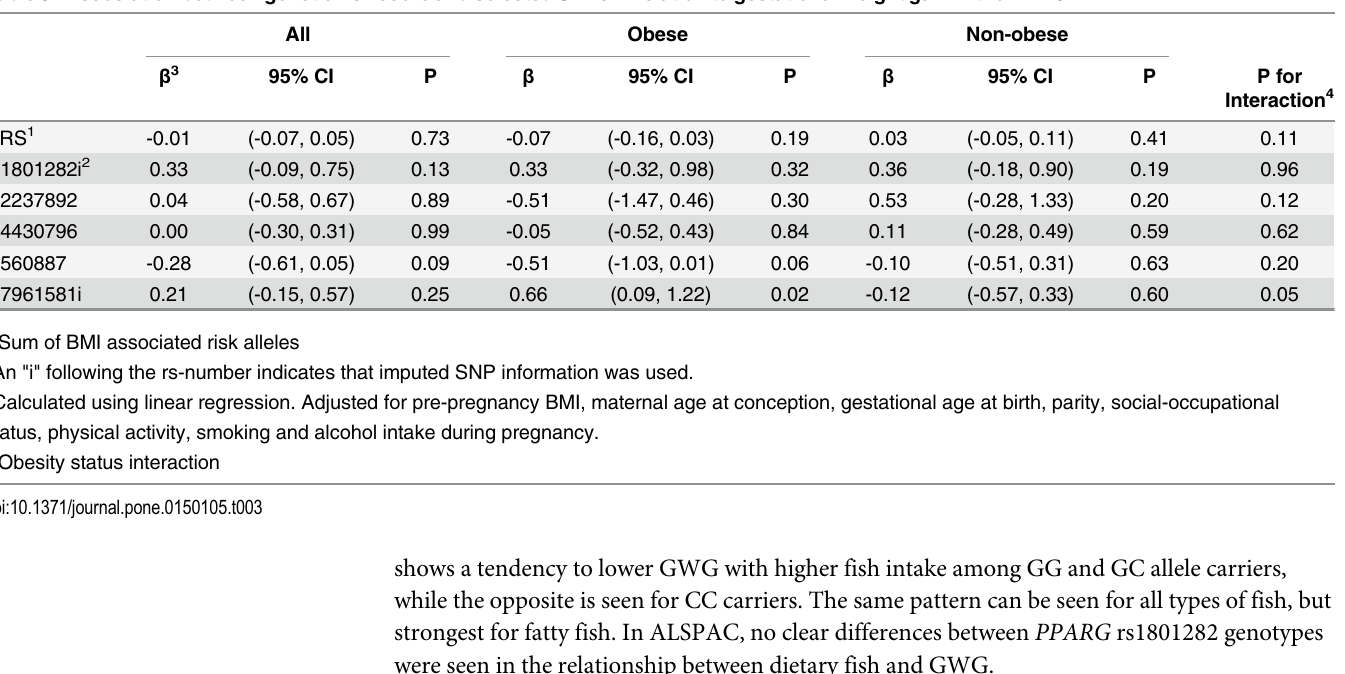
shows a tendency to lower GWG with higher fish intake among GG and GC allele carriers, while the opposite is seen for CC carriers. The same pattern can be seen for all types of fish, but strongest for fatty fish. In ALSPAC, no clear differences between PPARG rs1801282 genotypes were seen in the relationship between dietary fish and GWG.